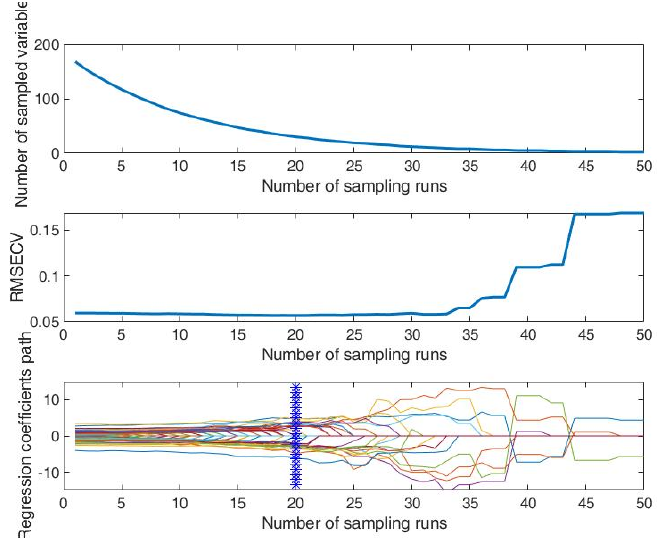
Figure 4. CARS screening methods to select feature wavelength